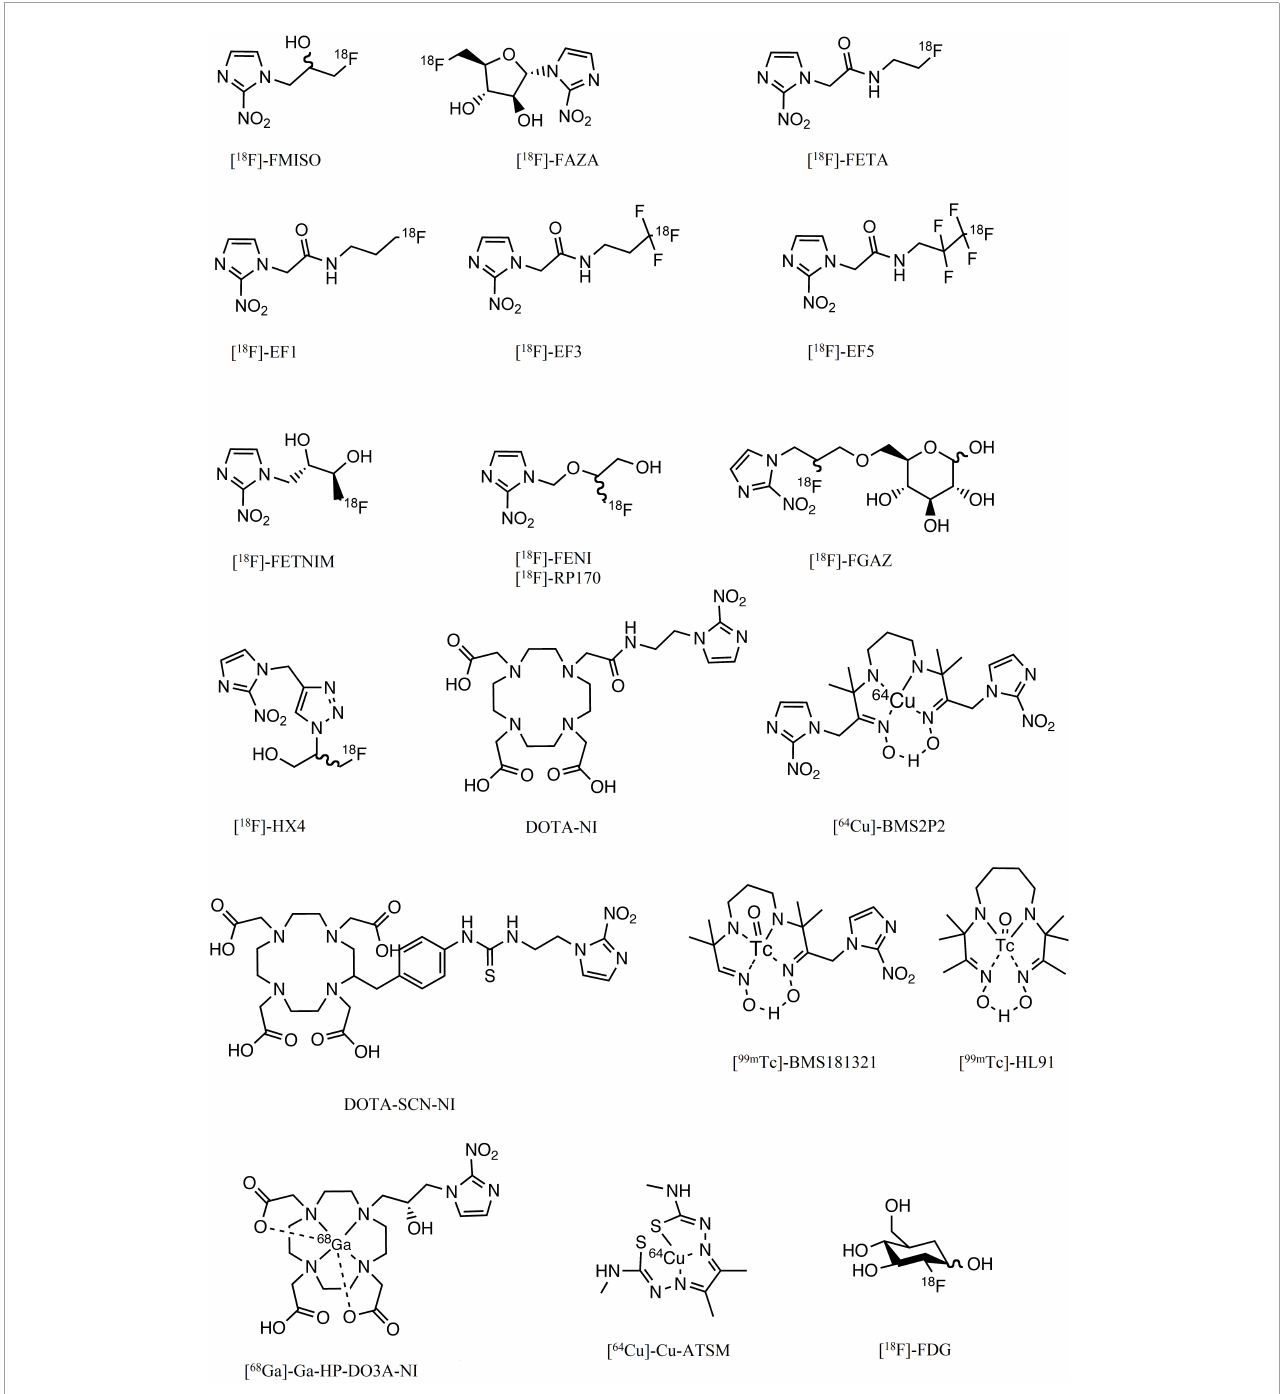
FIGURE2 Chemical structures of the main compounds used or having been used in the assessment of hypoxia.